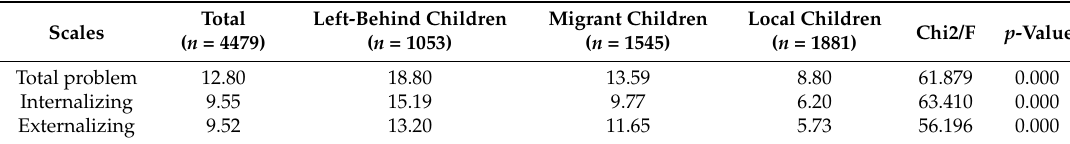
Table 3. Prevalence of total, internalizing and externalizing behavioral problems among the left-behind, migrant and local children